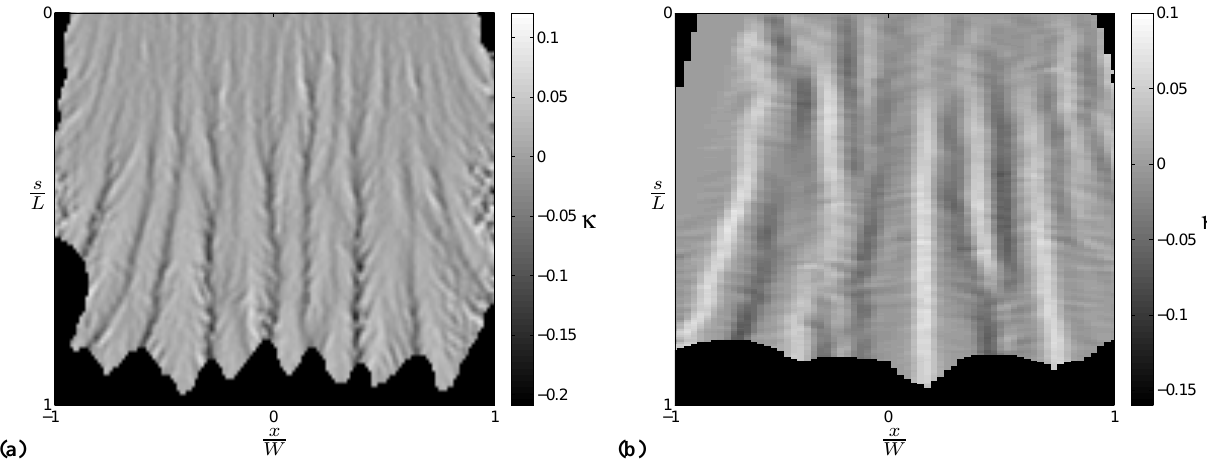
Fig. 6. (a) and (b) curvature ( κ ) of the level set T (x,y) calculated from the flows shown in Fig. 3a and b, respectively. Areas of negative curvature (dark) indicate the location of clefts, whilst areas of positive curvature (light) indicate the location of lobes.